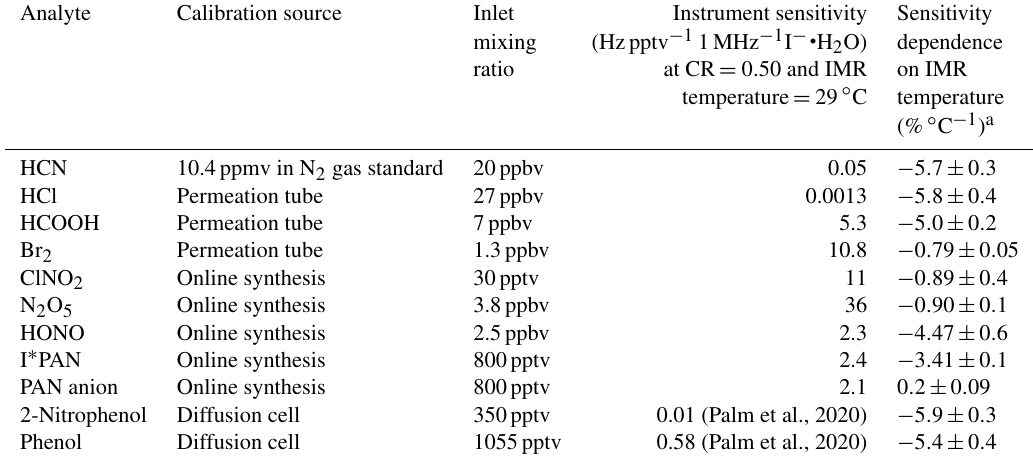
Table 1. The calibration sources, instrument sensitivity, and IMR temperature dependence of sensitivity for the analytes studied.